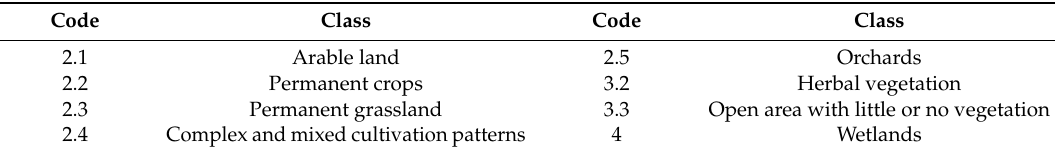
Table 4. The new classes of the UA